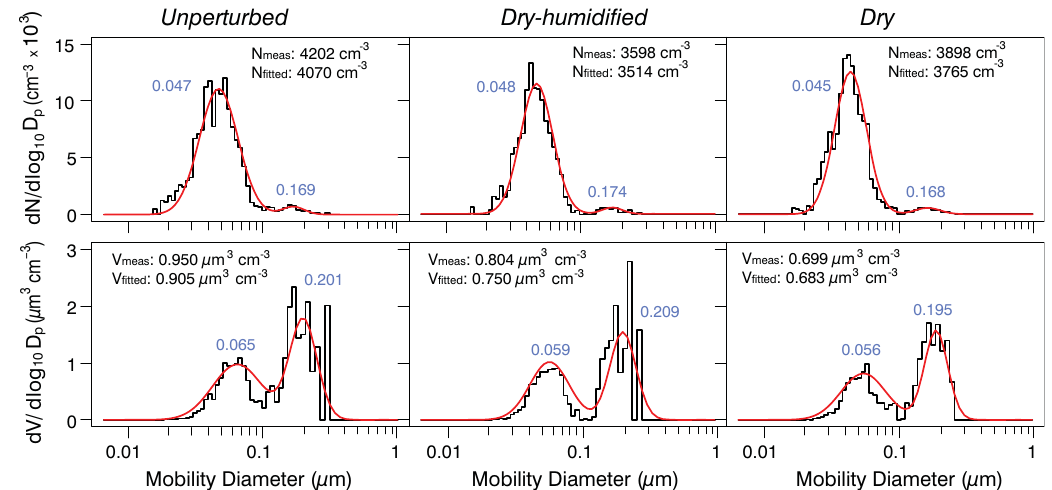
Figure 3. Example data from 5 July 2013. Histograms represent measured 60-bin representation of the number size distribution (top row) and derived volume size distributions (bottom row) for the unperturbed (left panels), dry-humidified (middle panels), and dry (right panels) instrument states. Red lines correspond to a bimodal lognormal distribution fitted to the data. Data-derived and fit-derived number and volume concentrations are provided in the legend. Blue numbers indicate the mode diameters obtained from the fit to the